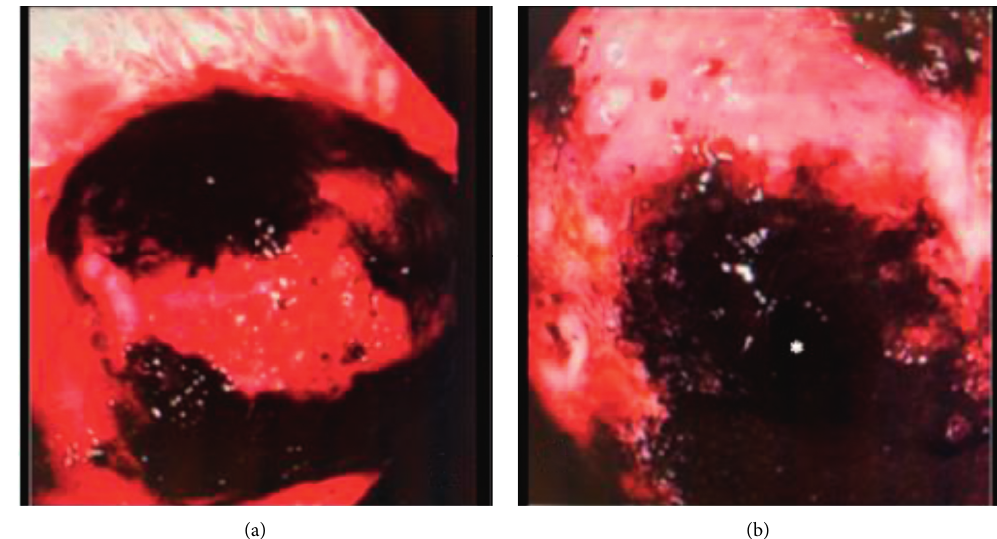
Figure 1: (a) Dominant ulceration along the greater curvature. (b) Image within ulceration revealing fistula opening leading to pleural space marked by the